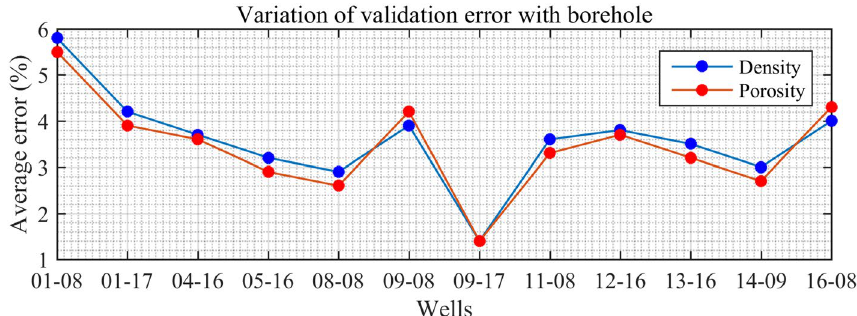
Fig. 11 Variation of validation error with wells for porosity and density